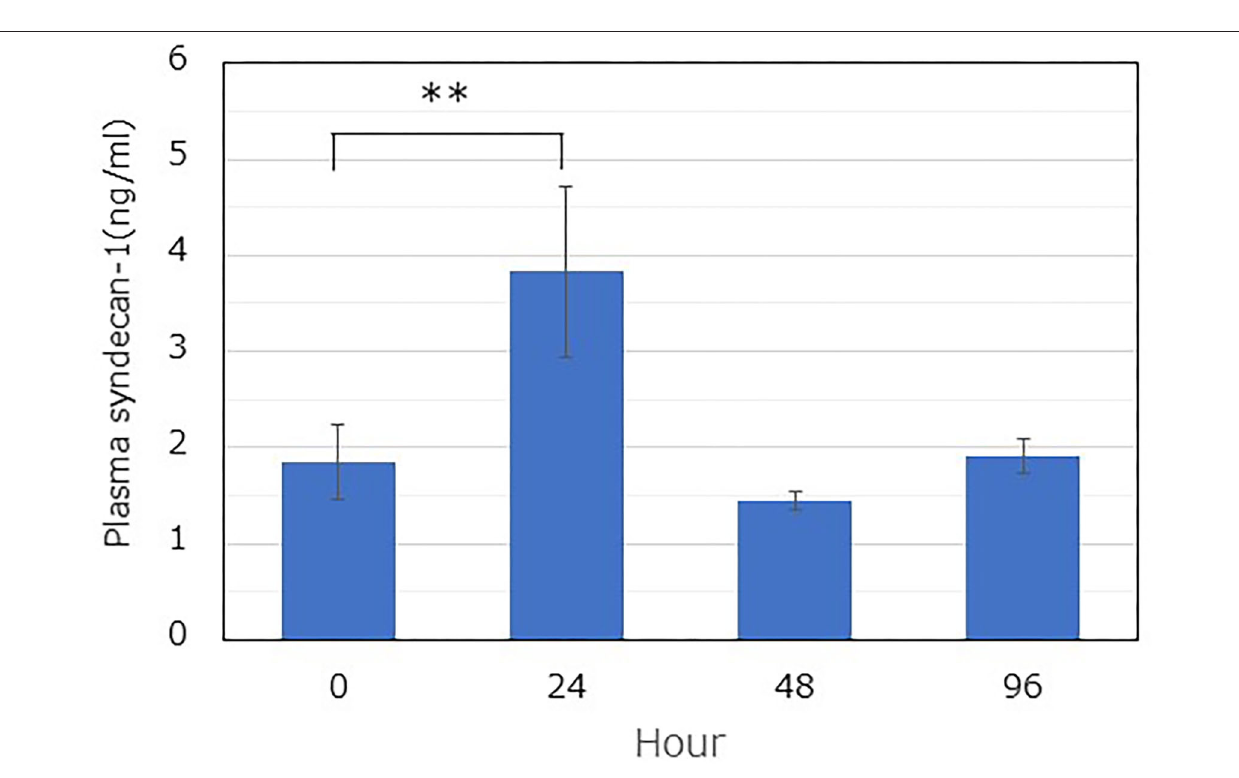
FIGURE 2 | Time-dependent changes in the soluble plasma syndecan-1 level after LPS administration. The plasma level was determined using a commercially available ELISA kit. LPS was immediately administered after blood collection at 0h. Blood was collected from similar mice ( n = 3), and the plasma was extracted by centrifugation. A one-way ANOVA was performed, and the Dunnett’s test was conducted for post-hoc comparisons (** P <